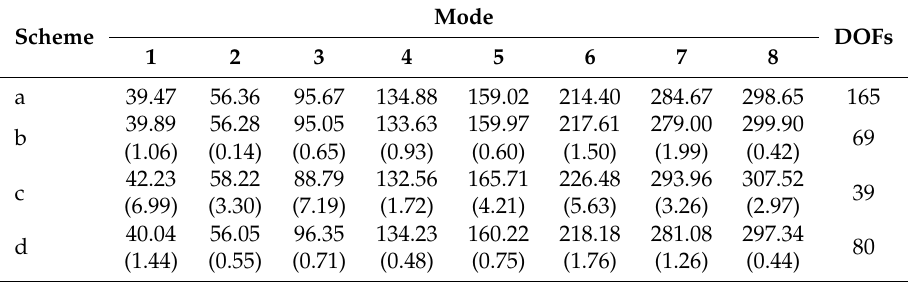
Table 2. The first eight natural frequencies of the beam f (Hz) and relative error e (%).